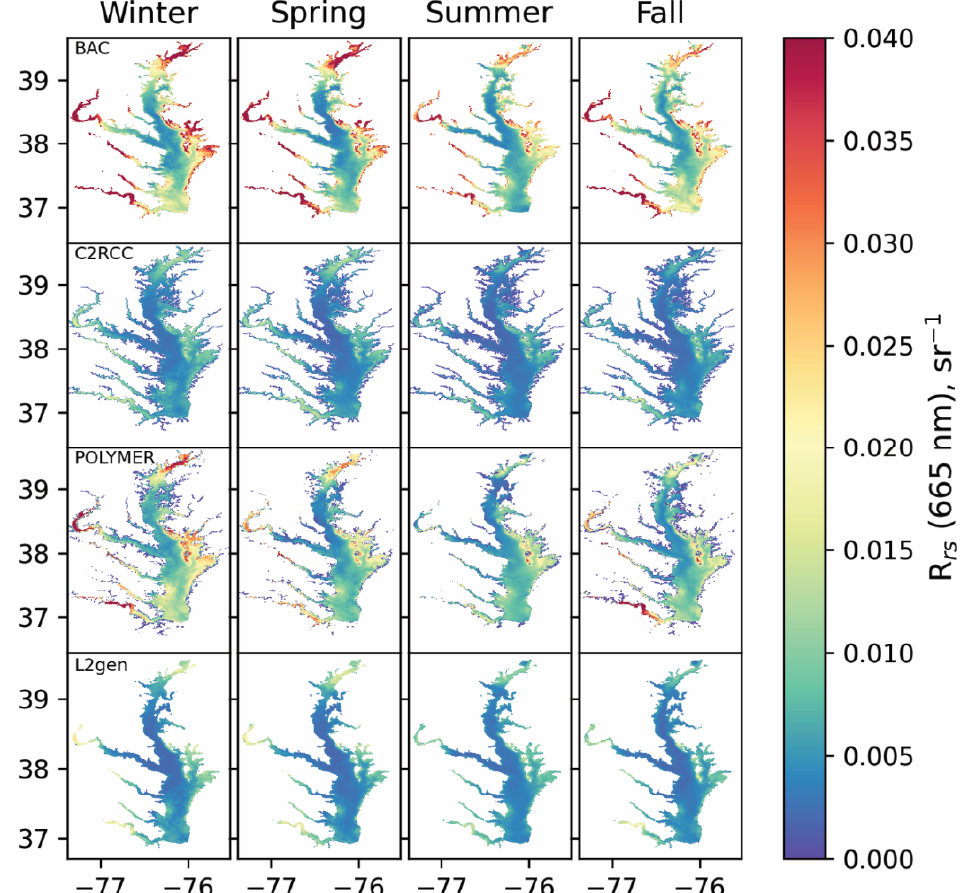
Figure 8. Seasonal climatologies of R rs at 665 nm for the year 2020 derived by each atmospheric correction algorithm.